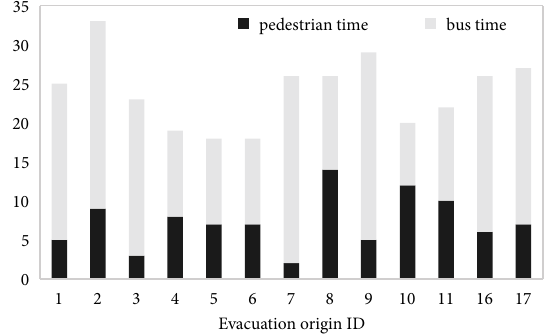
Figure 5. Evacuation during time for each evacuation origin under Scenario 2